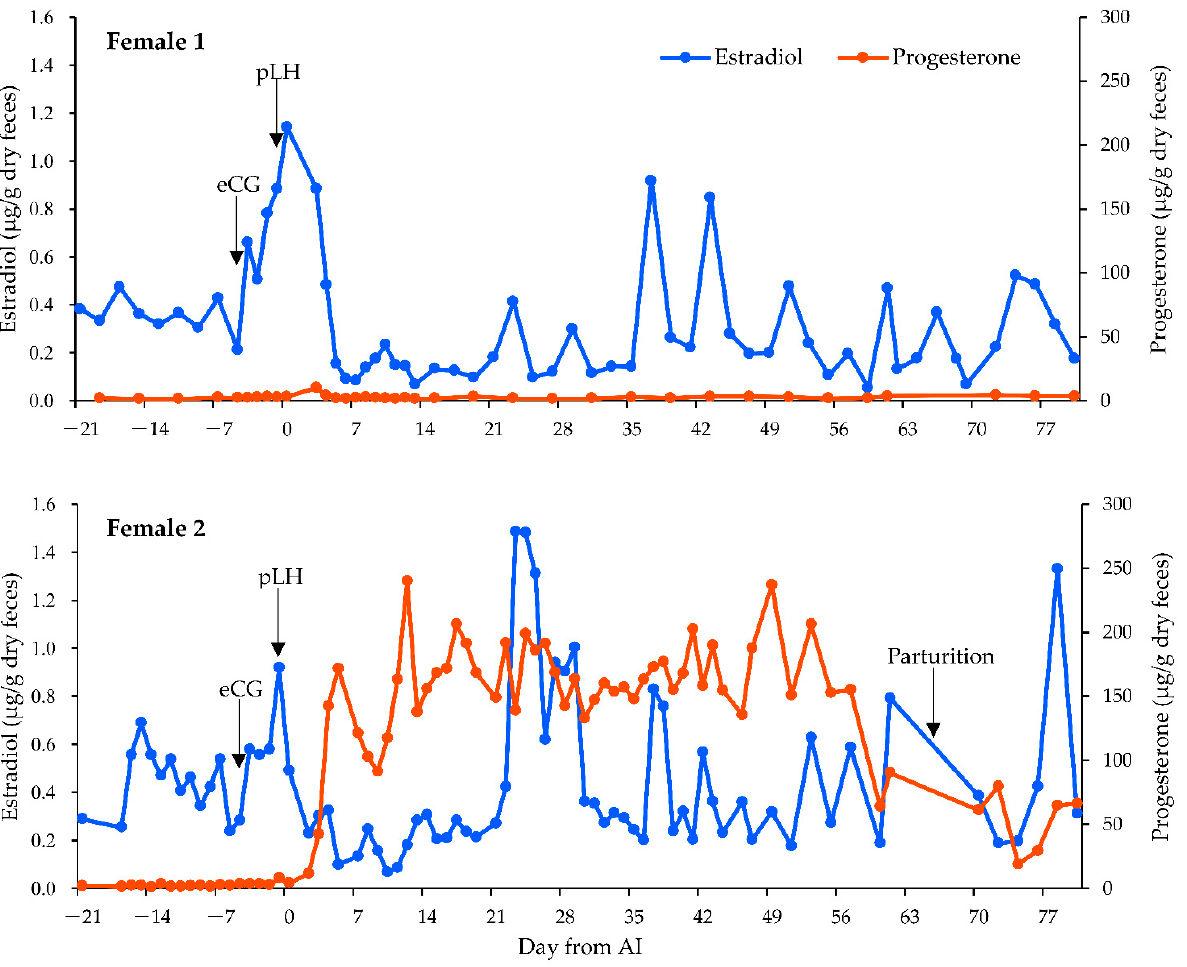
Figure 2. Fecal hormone concentrations of the two female Tsushima leopard cats studied. The blue line represents estradiol-17 β (E2), whereas the orange line represents progesterone (P4). Day 0 indicates the day of artificial insemination (AI). The day of administration of each equine chorionic gonadotropin (eCG) and porcine luteinizing hormone (pLH) are noted for each female.